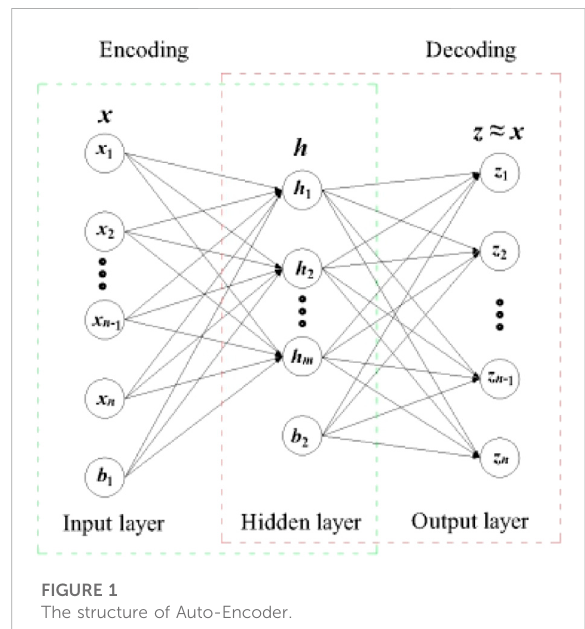
FIGURE 1 The structure of